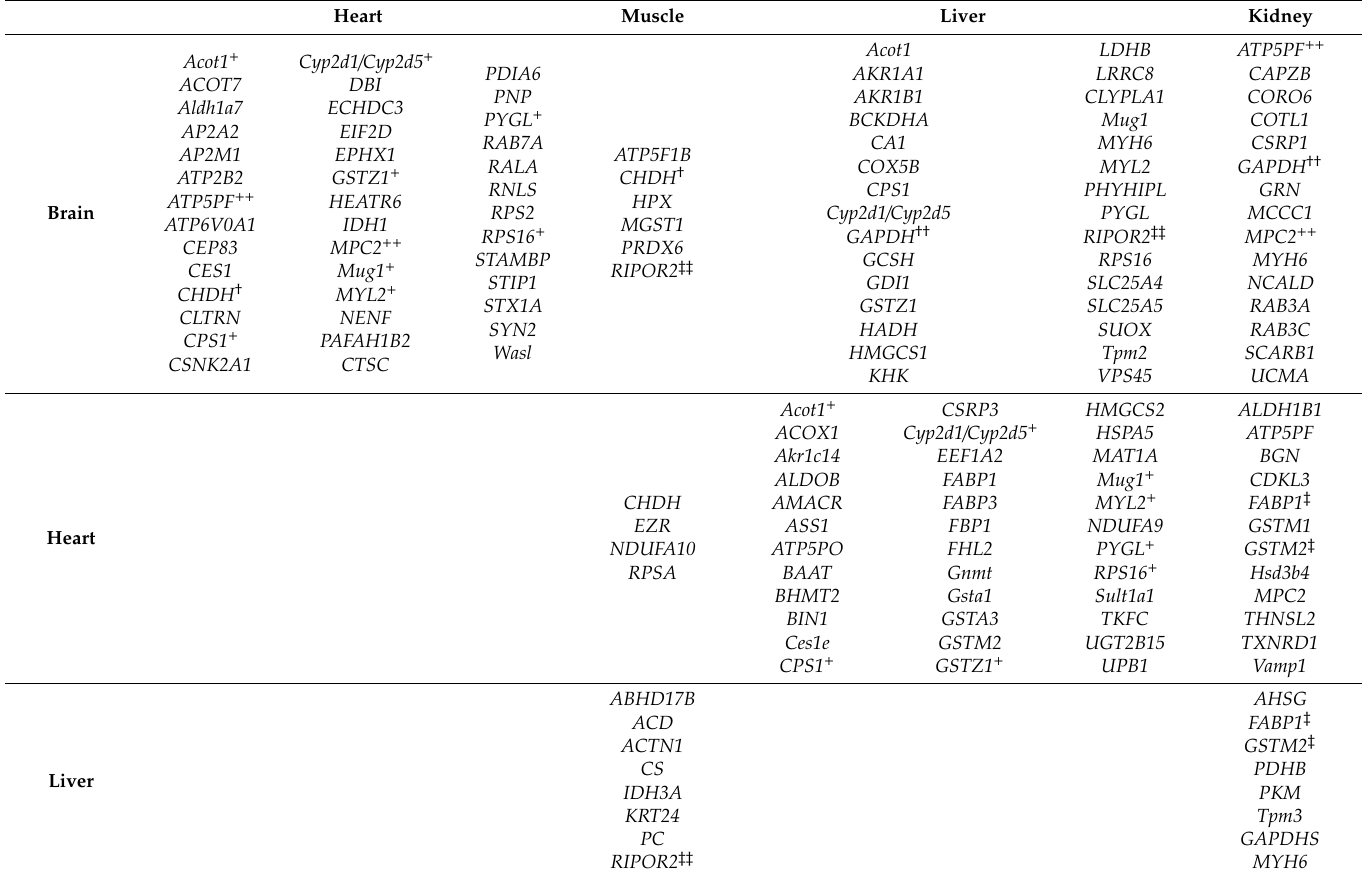
Table 1. This table shows the identity (gene name) of the proteins found to be overlapping between the di ff erent organs. The proteins found in common among the di ff erent organs are marked as: + common in heart, brain, liver; ++ common in heart, brain, kidney; ‡ common in kidney, heart, liver; ‡‡ liver, muscle, brain; † common in brain, heart, muscle; and †† common in brain, kidney,